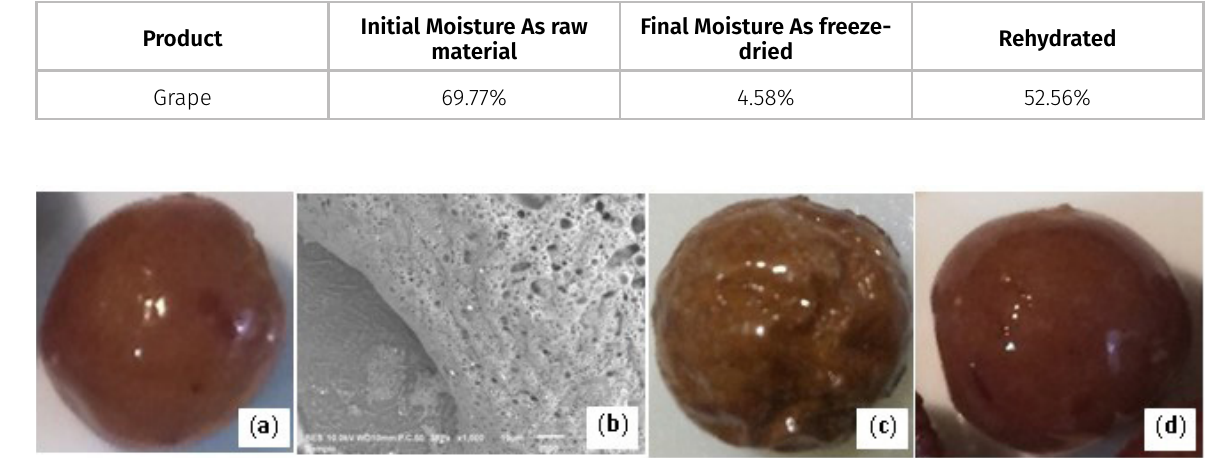
Table I. Shows moisture percent in product through different steps of dried process.